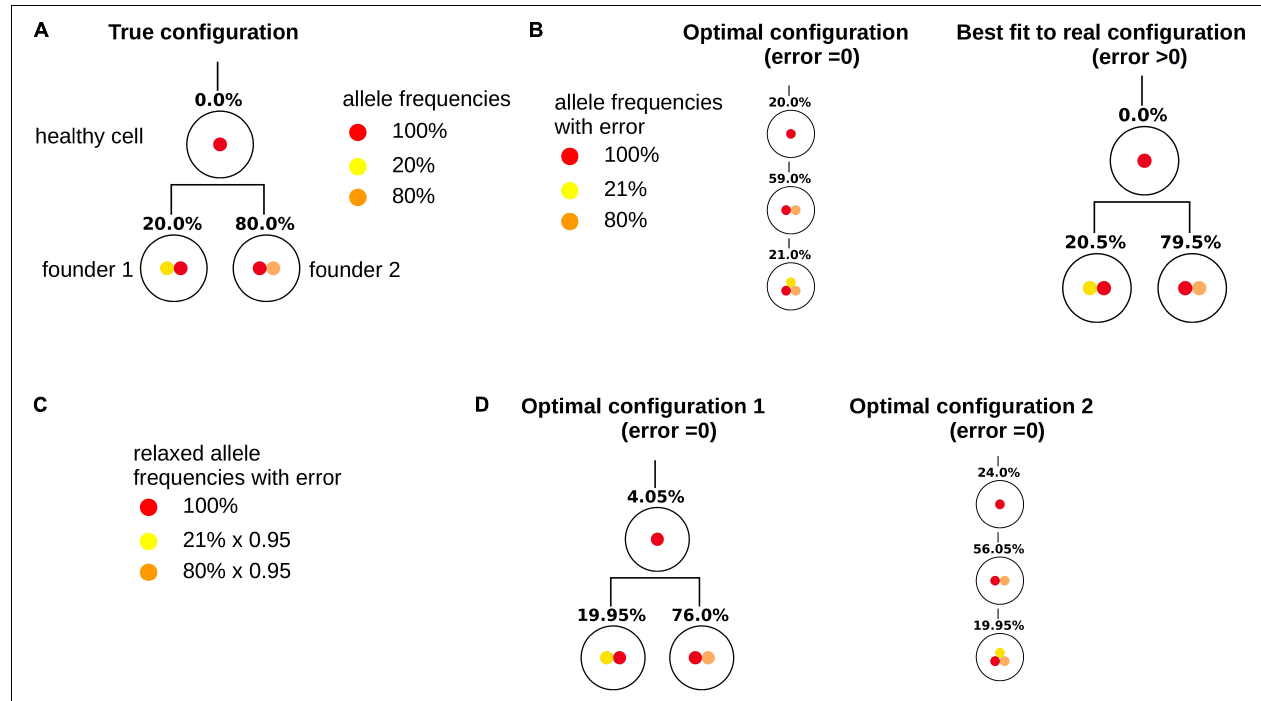
FIGURE 9 | Relaxation of measurements. This figure demonstrates how relaxation of the VAF can help to make the true configuration an optimal configuration. (A) True configuration with two founder clones. Wild type cells are added to the tree to have a unique root. Since the sample only contains leukemic cells the frequency of wild type cells equals zero. The frequencies of the two founder clones add up to 100%. (B) Variant allele frequencies are perturbed by a measurement error. The frequencies of the two founding mutations no longer add up to 100%. Therefore the true hierarchy is no longer an optimal hierarchy. (C) By multiplying the frequencies of mutated alleles with 0.95 we artificially add 5% of healthy cells to the sample. (D) If we reconstruct the clonal hierarchies for the modified data the true hierarchy is among the optimal hierarchies.